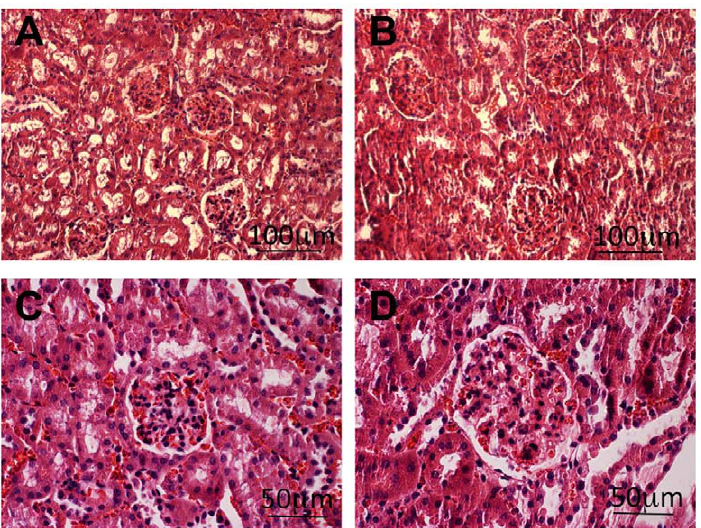
Figure 4. Enlarged glomeruli in seven month old db/db mice. Panels A and C are controls, and panels B and D are from db/db mice. Panels A and B are lower magnification views showing multiple glomeruli, while panels C and D are higher magnification, more clearly showing the size difference. Sections were hematoxylin and eosin stained.